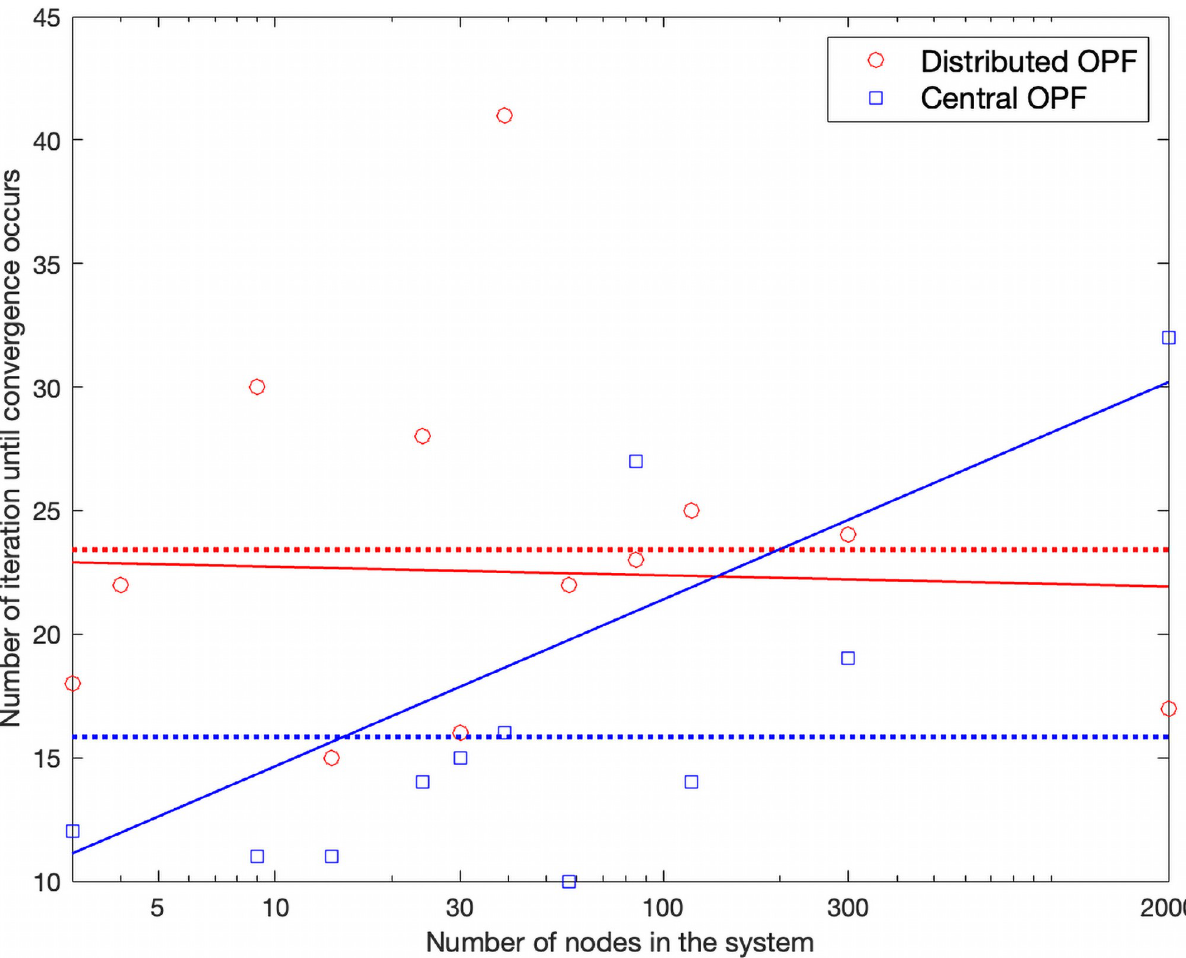
Fig 10. N iter for central OPF and of the proposed algorithm on the tested systems. Dotted lines are averages, and solid lines are best-fit curves.